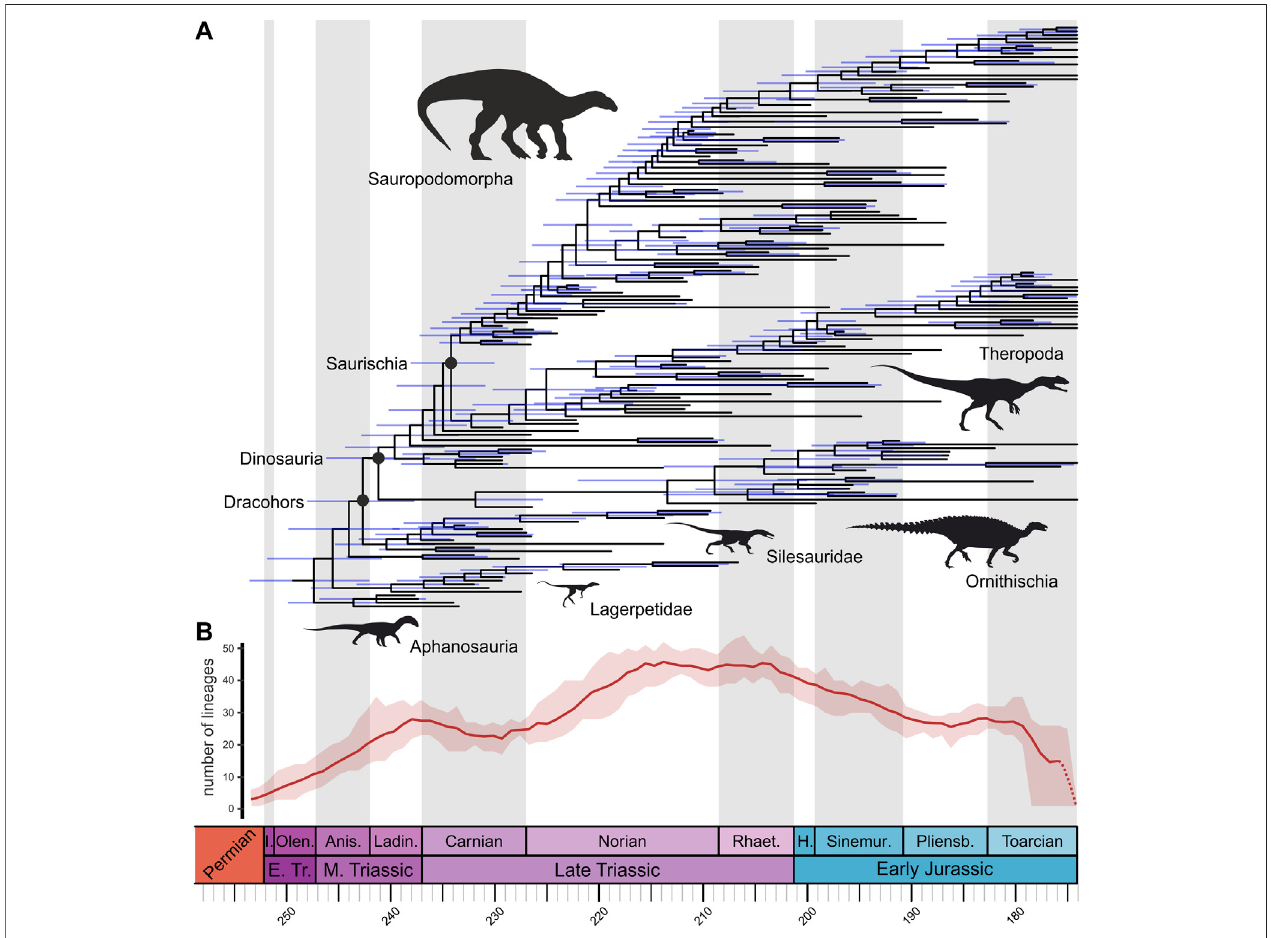
FIGURE 1 | (A) Time-calibrated phylogeny (majority rule consensus tree) of Triassic to Early Jurassic pan-avians (excluding pterosaurs), obtained from Bayesian analysisusingthefossilizedbirth – deathmodel. Phylogenetic relationshipsasinoursupertree ST1(silesaurids externaltoDinosauria,theropodsforming Saurischiawith sauropodomorphs, and herrerasaurs external to Eusaurischia). Blue bars indicate 95% highest posterior density age ranges of nodes. (B) Through-time phylogenetic diversity (lineage-through-time) of terrestrial Pan-Aves. Dark red solid line represents mean values for the ten trees from topology ST 1 with “ ghost lineages, ” whereaslightredshaderepresentsmaximumandminimumvaluesforthosesametentrees.DashedredlinerepresentstheuncertaintyofpatternsthroughtheToarcian, fromapossible “ edgeeffect. ” Timescaleabbreviations:Anis.=Anisian;H.Hettangian;I.=Induan;Ladin.=Ladinian;Olen.=Olenekian;Pliens.=Pliensbachian;Rhaet.= Rhaetian; Sinemur. =